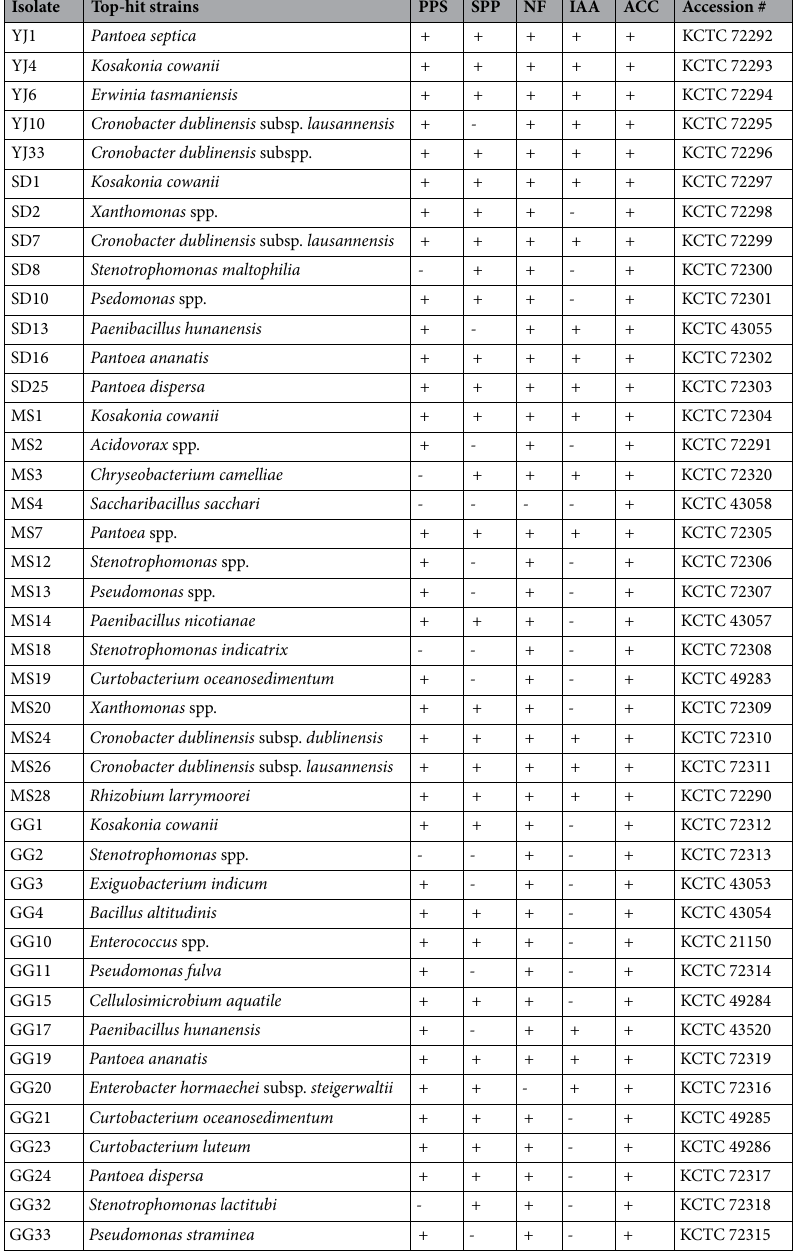
Table 1. Results of the PGP traits in 42 representative isolates. Positive and negative results for each trait are indicated by ‘ + ’ and ‘ − ,’ respectively. PPS, Phosphate solubilization; SPP, Siderophore production; NF, Nitrogen fixation; IAA, Indole acetic acid production; ACC, 1-aminocyclopropane-1-carboxylate deaminase